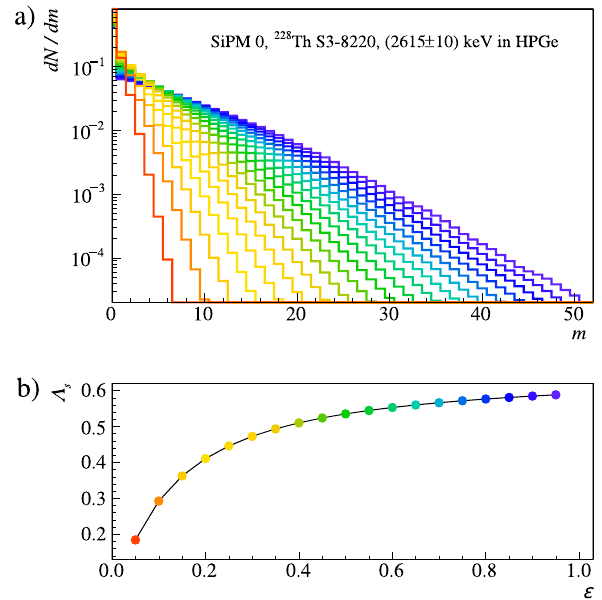
Fig. 4 Binomial repopulation. a The pmf Λ s [ m ] (ε) defined in Eq. 4 can be obtained for any value of the detection efficiency ε from the unaltered simulation output. The example shows the pmf for a specific SiPM channel as obtained for 228 Th decays in a calibration source at the top of the array (see also Tab. 1) depositing 2615 ± 10 keV in the HPGe detectors. The result is plotted for a selection of efficiency values, reported in the bottom panel. b The panel shows the non-linear dependence of the light detection probability Λ s (defined in Eq. 5). The color coding relates data points with corresponding distributions in the top